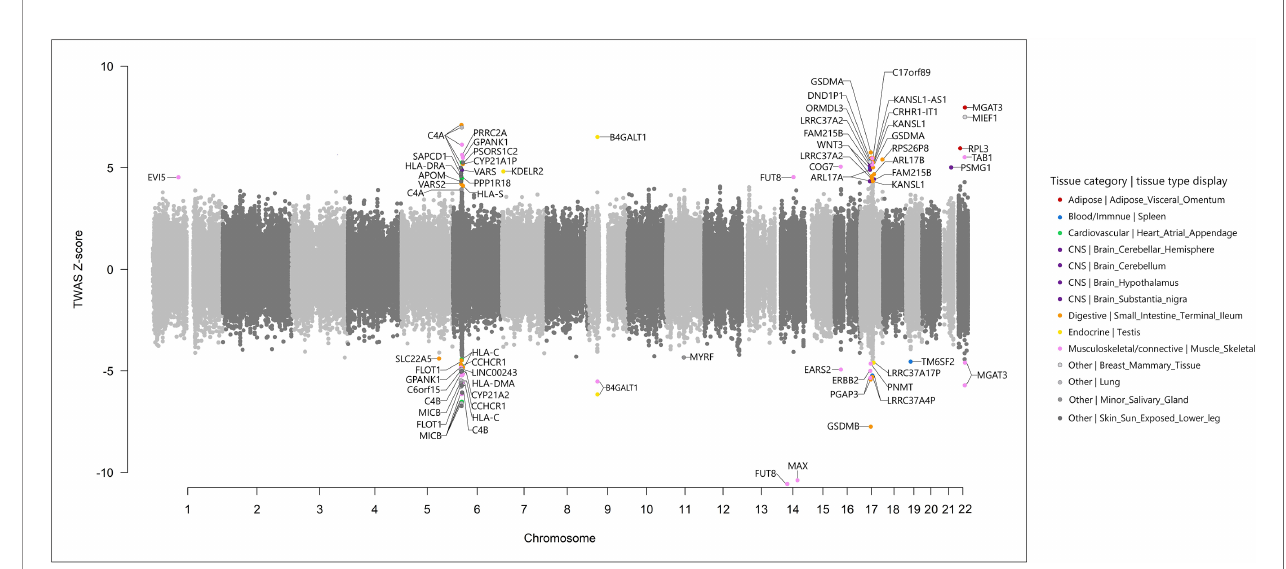
FIGURE 3 | Miami plot of the transcriptome-wide association study for IgG N-glycosylation ( n = 8,090) using gene expression models in 24 tissues. Each point refers to a single gene tested, with the physical position plotted on the x -axis, and a Z -score of association between gene expression and IgG N-glycan peaks plotted on the y -axis. Bonferroni-adjusted signi fi cant genes within corresponding transcriptome panels are labeled in multiple colors according to different tissue categories and tissue